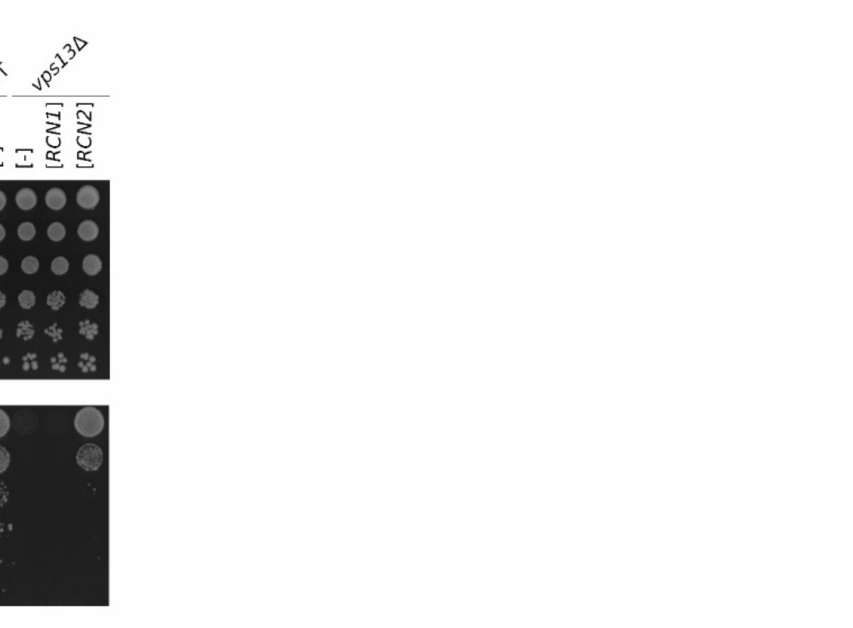
Figure 1. RCN2 , but not RCN1 , is a multicopy suppressor of the sodium dodecyl sulfate (SDS) hypersensitivity phenotype of the vps13 ∆ mutant. Serial dilutions of wild-type and vps13 ∆ strains transformed with empty vector [-] or vector bearing RCN2 or RCN1 genes were plated on YPD and YPD + SDS media. Plates were incubated for 3